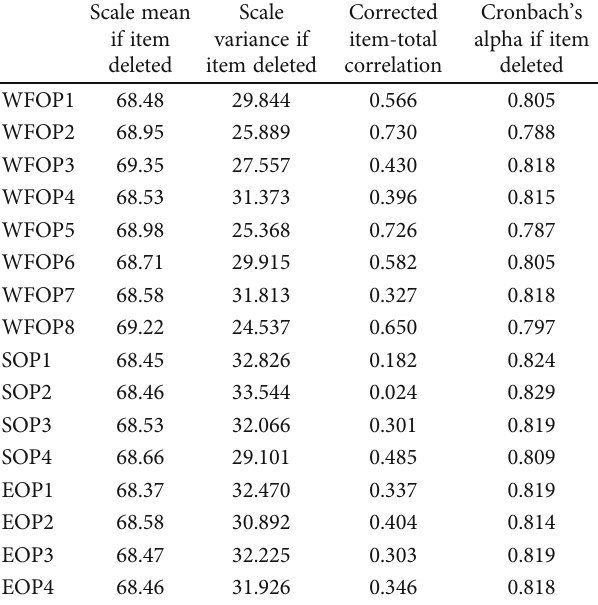
Table 9: Item-total statistics for independent variable (CSR